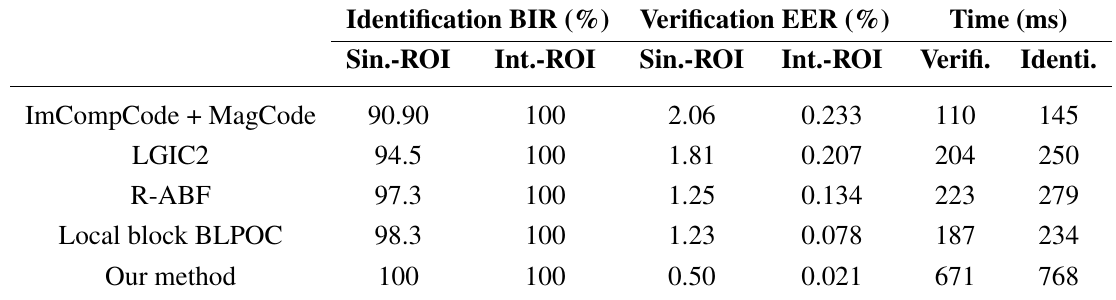
Table 1. Comparison of the five methods based on Database 1 (DB-1) in terms of accuracy and time performance. Note that “Sin.-ROI” and “Int.-ROI” are the abbreviations of single ROI and integrated ROI recognition, respectively. Here, we compute the time that is spent for verification or identification for one test dataset in integrated ROI mode. BIR, best identification rate; EER, equal error